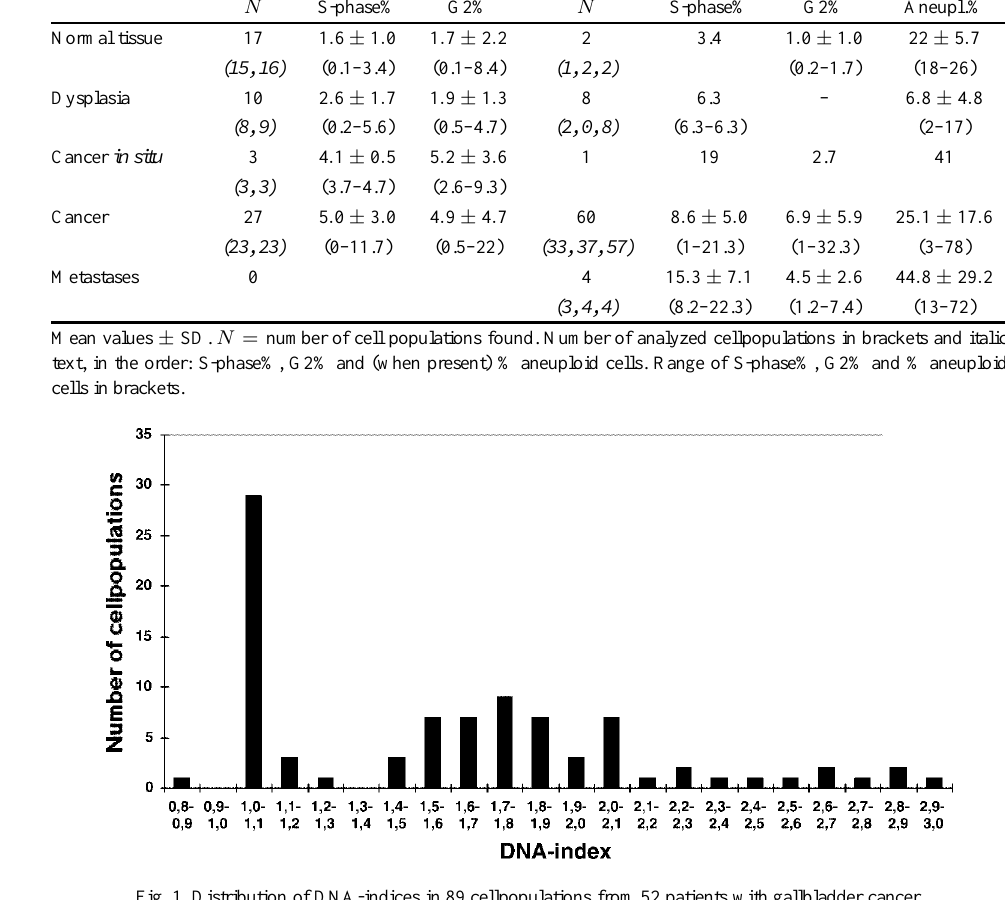
Fig. 1. Distribution of DNA-indices in 89 cellpopulations from 52 patients with gallbladder cancer.